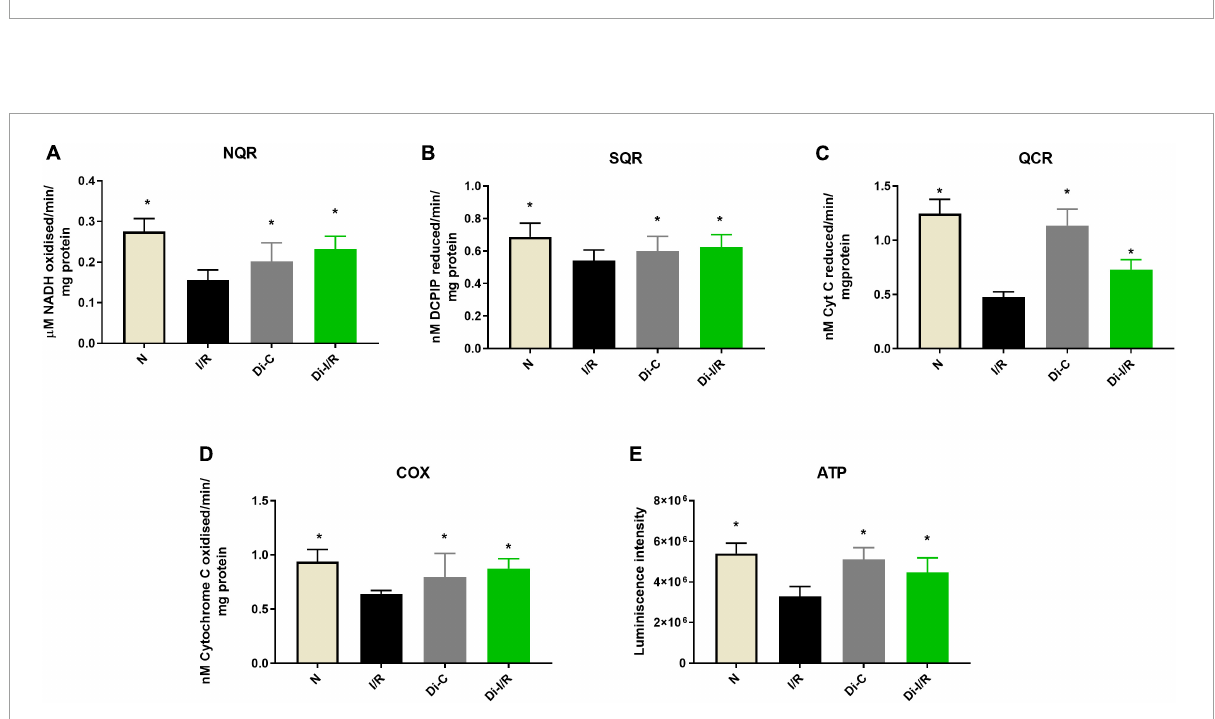
FIGURE7 Inhibition of DNA methylation improved the mitochondrial function post-I/R. The effect of DNA methylation inhibition on mitochondrial function was assessed by evaluating the electron transport chain enzyme activities of complexes (A) NQR (Complex I); (B) SQR (Complex II); (C) QCR (Complex III); (D) COX (Complex IV). Panel (E) shows the ATP content. The graphs represent mean ± SD values. * p < 0.05 vs.